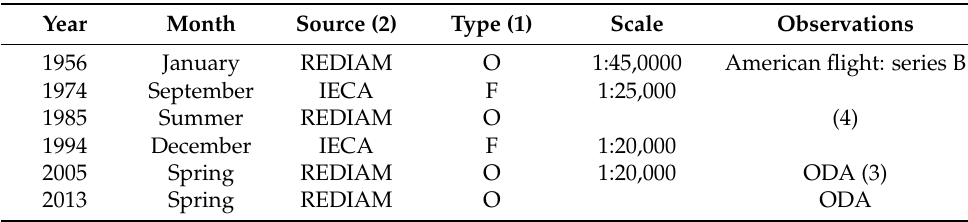
Table 2. Aerial photographs and orthophotographs